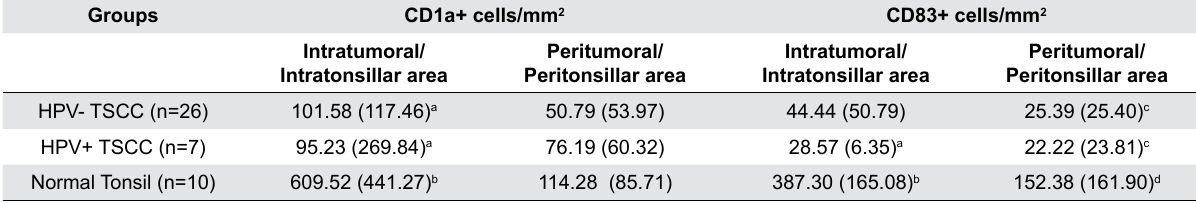
Table 3- Quantification of CD1a+ and CD83+ dendritic cells of all groups (median and interquartile range)